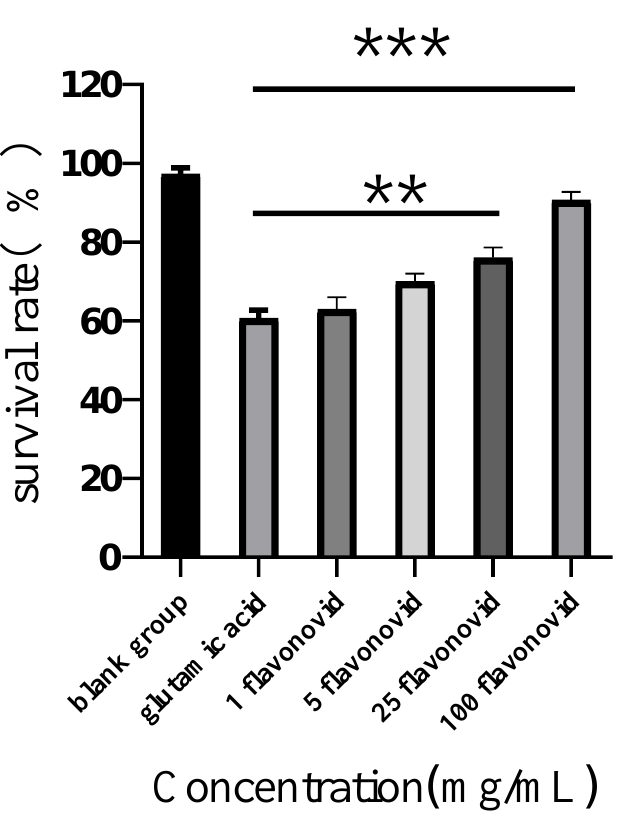
Figure 4. The protective effect of flavonoids on HT-22 cells (** p < 0.01, *** p < 0.0001)